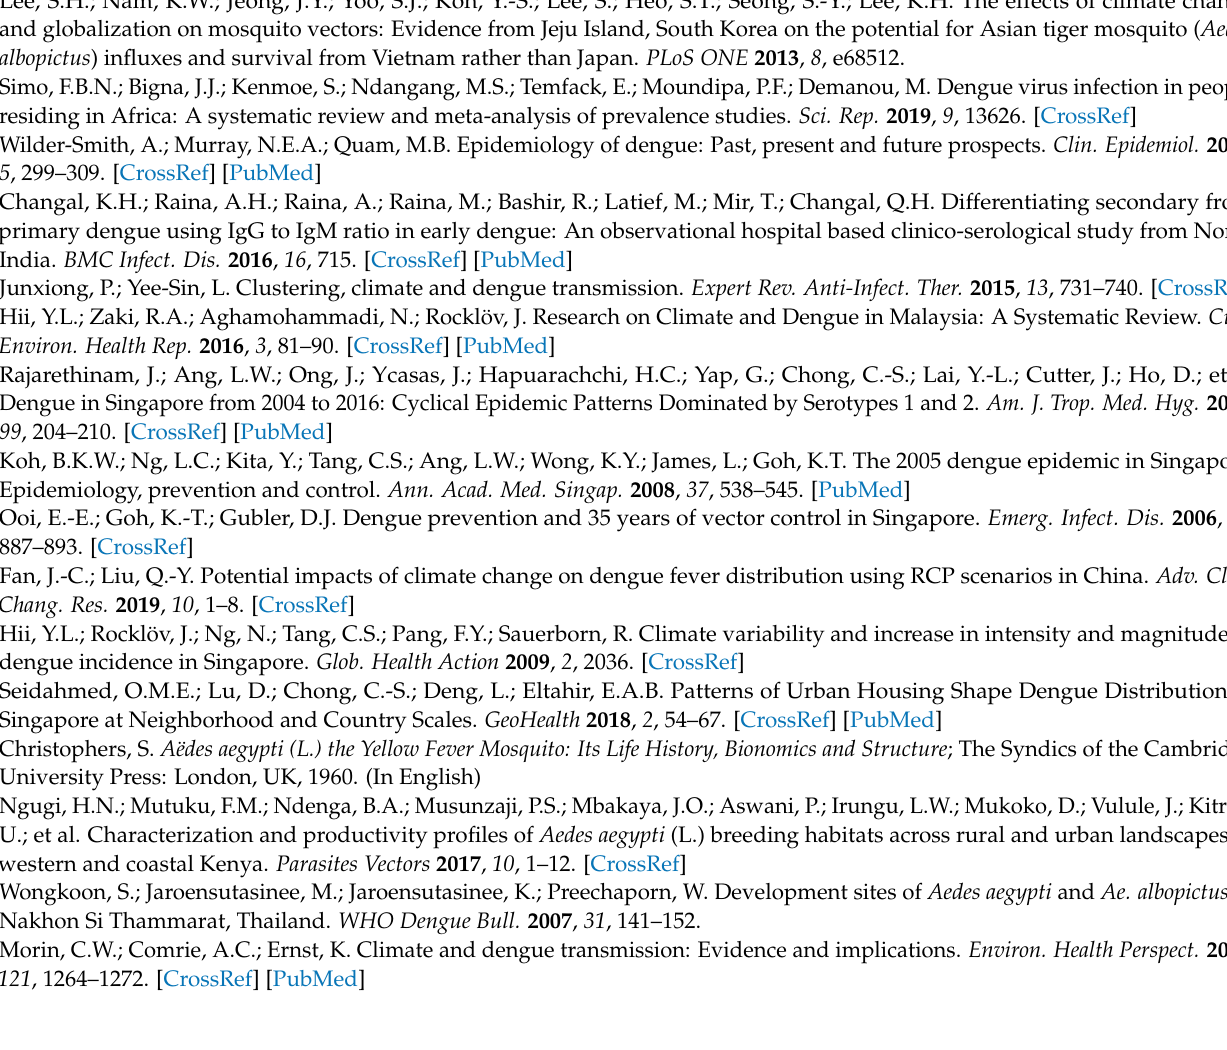
Table S1: Epidemiological characteristics of dengue cases in Singapore from 2012–2019; Table S2: Estimated parameters of distributed lag non-linear model; Table S3: Predictive model performance using 2012–2018 data as training data and 2019 data as test